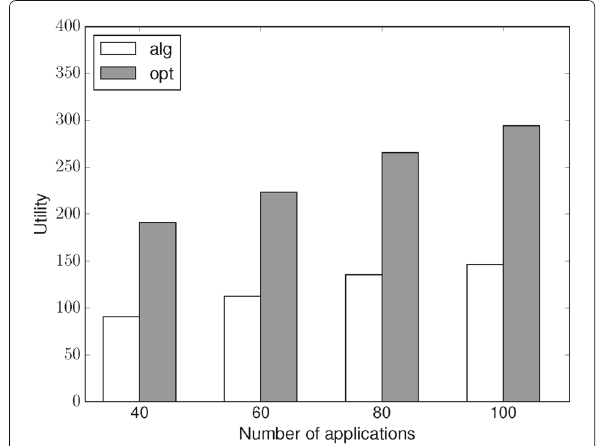
Fig. 8 Scheduling with single